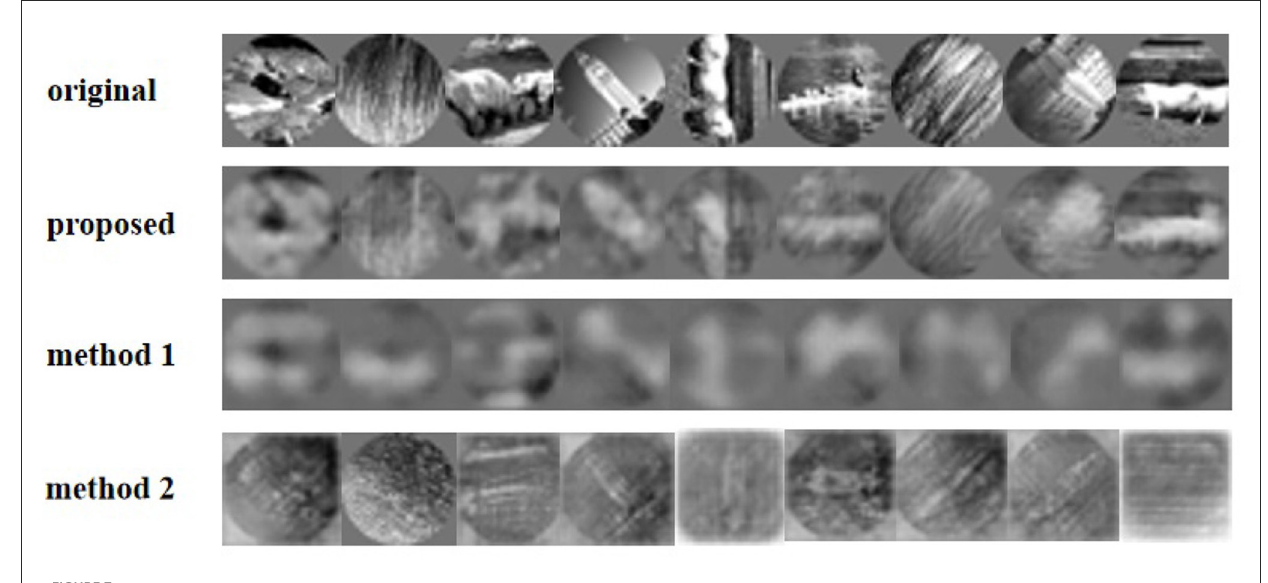
FIGURE7 Reconstruction of the natural images using different methods from V1 neurons.